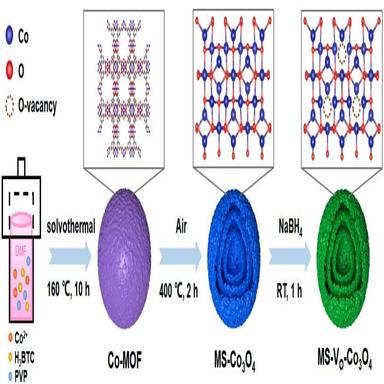
TEM images of (a) Co-MOF, (b, c) MS-Co3O4 and (d-f) MS-VO-Co3O4. (g) HRTEM image and (h) EDX elemental mappings of MS-VO-Co3O4.